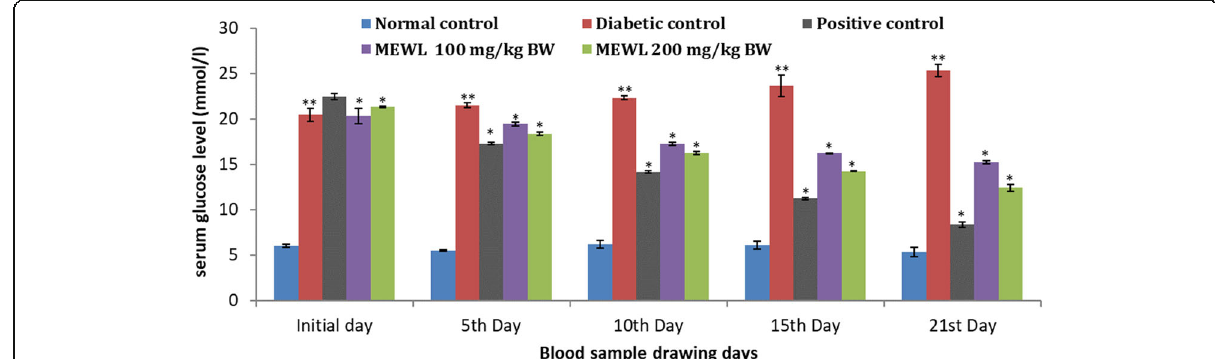
Fig. 3 Effects of MEWL treatment on blood glucose levels in alloxan induced diabetic mice. All data are expressed as mean ± SD (n; number of mice = 5). Here “ ** ” indicates p < 0.01 vs normal control mice and “ * ” indicates p < 0.01 vs diabetic control mice